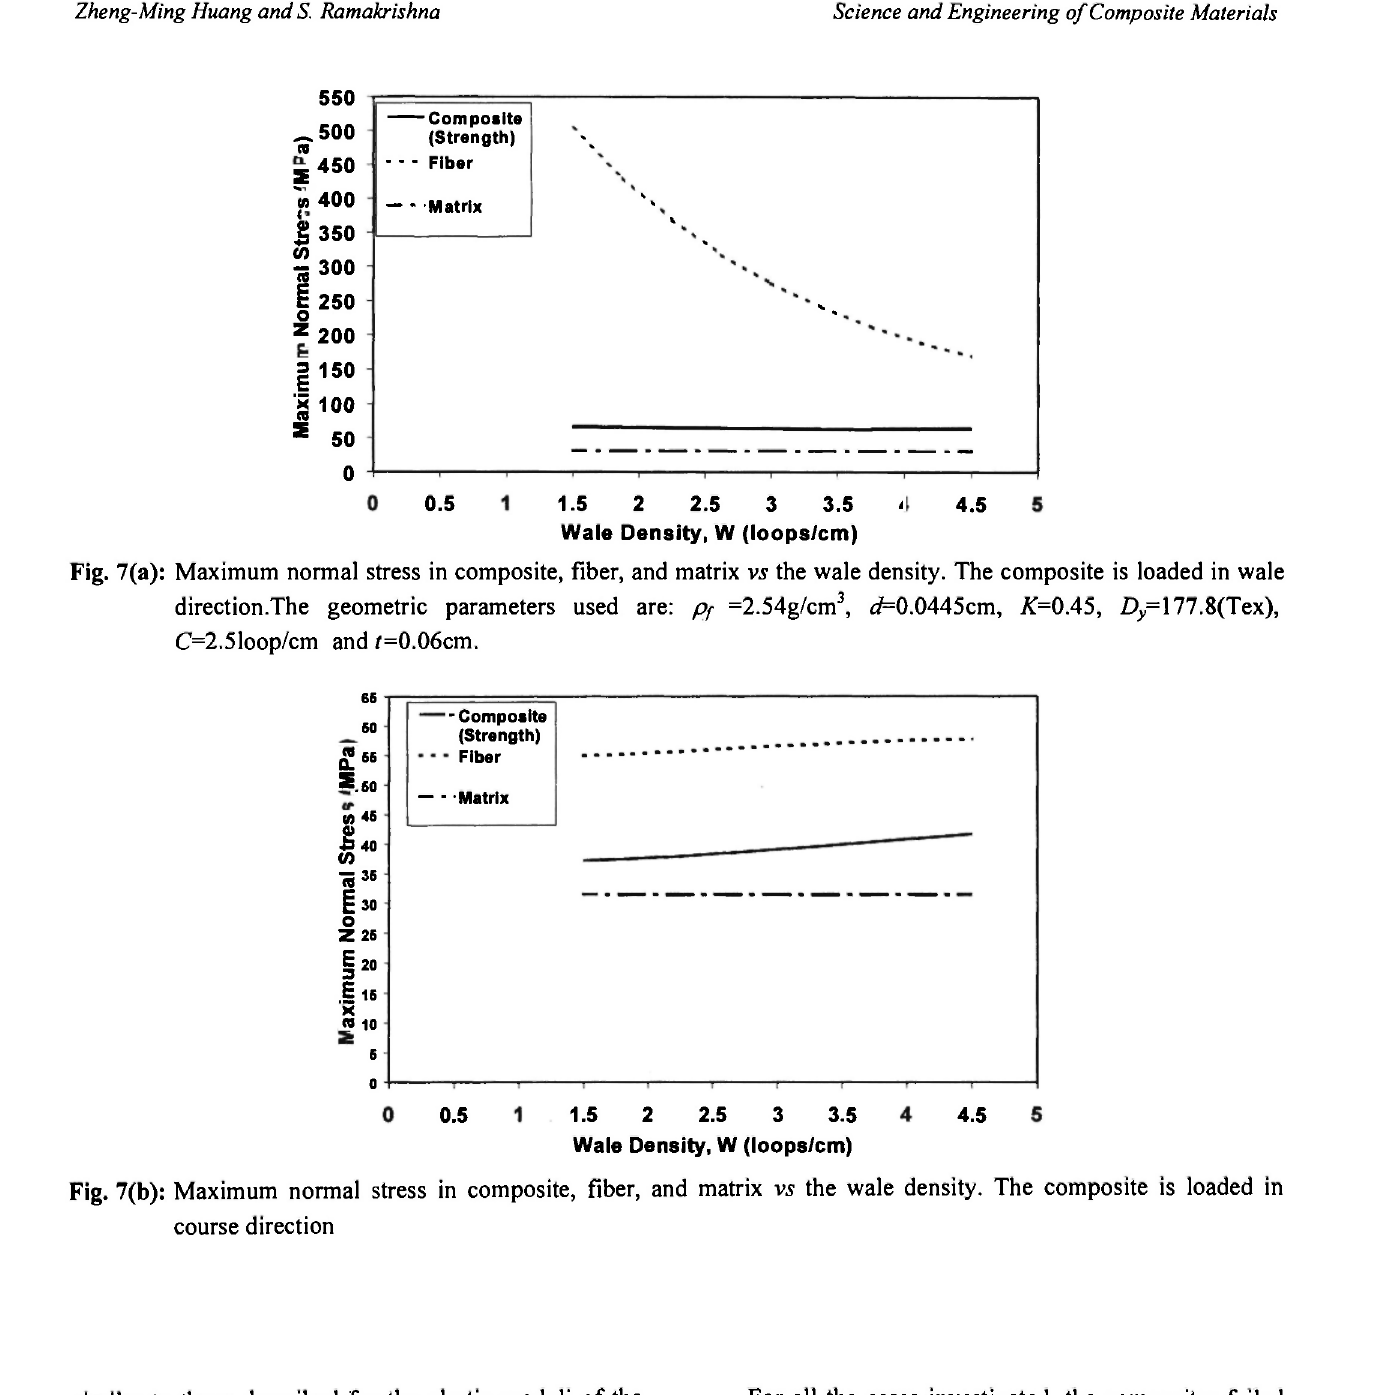
Fig. 7(b): Maximum normal stress in composite, fiber, and matrix vs the wale density. The composite is loaded in course